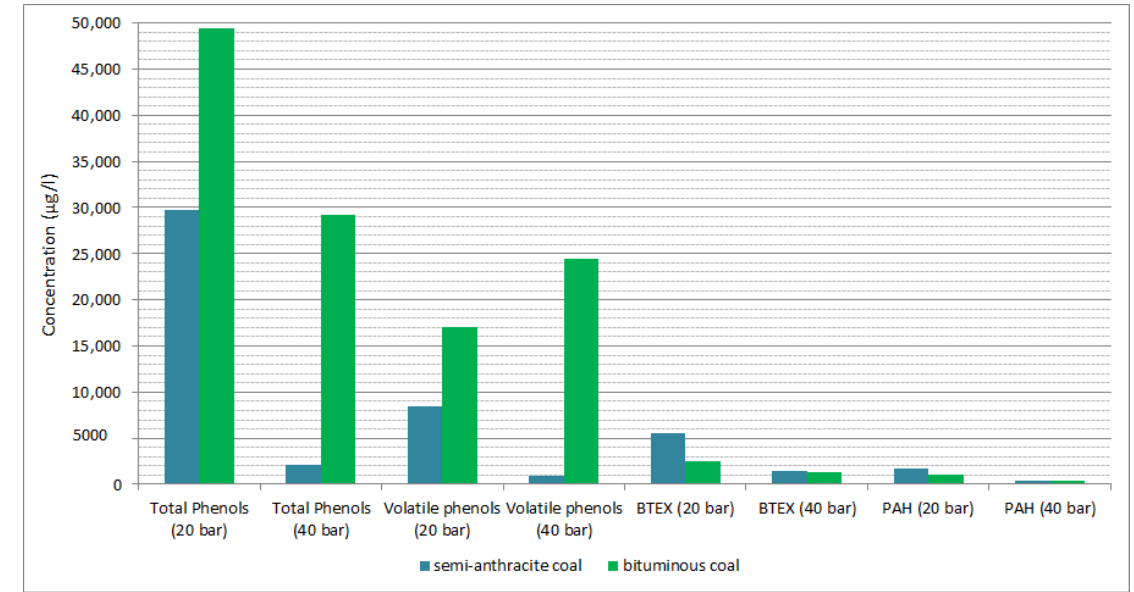
Figure 3. Concentrations of selected organic contaminants in wastewater from gasification experiments—coal type